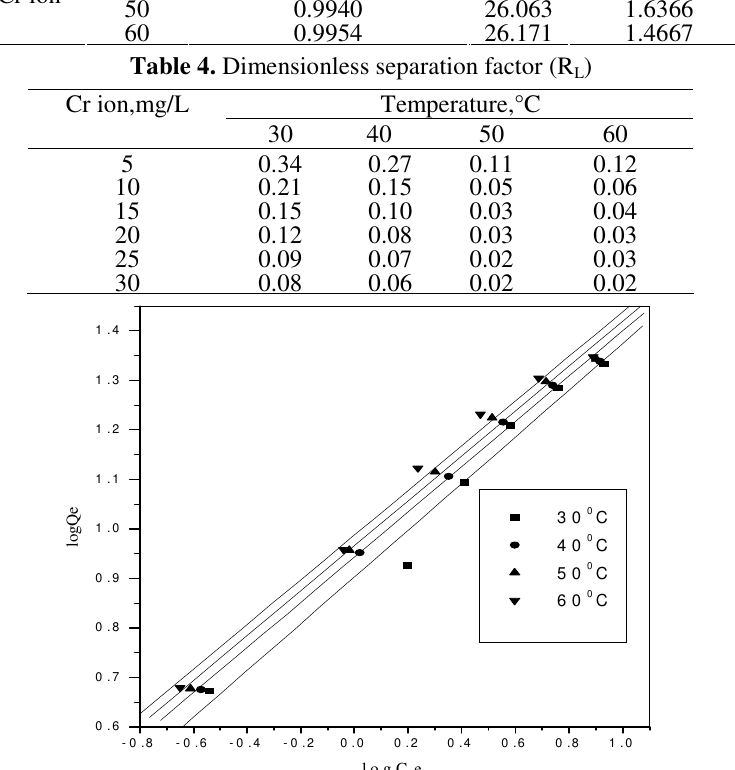
Figure 4. Freundlich adsorption isotherm for the removal of chromiumion onto